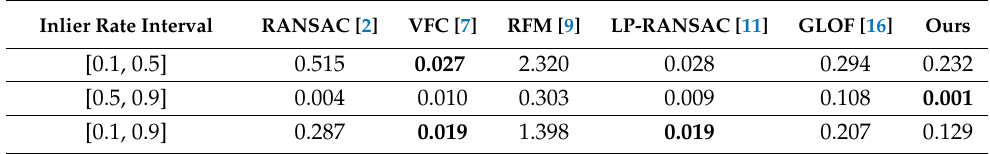
Table 4. Average execution time (in seconds) comparison for the “Airport”